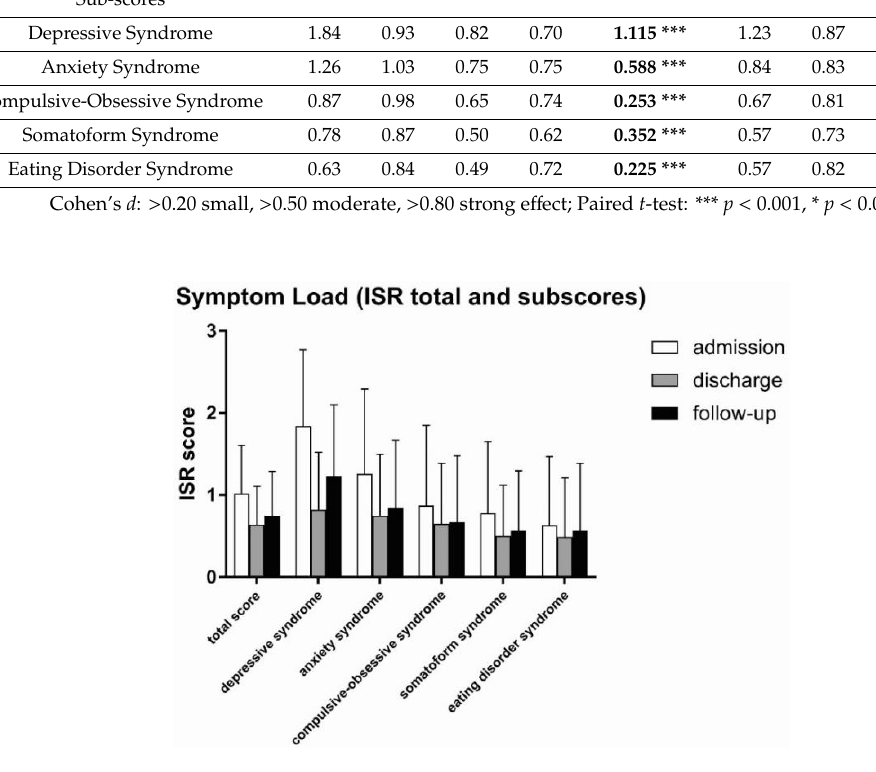
Figure 4. Effect of multimodal intervention. The scatter blots illustrate the effect of the multimodal intervention at ( A ) discharge from the TCM Hospital or ( B ) follow-up. Each dot represents one patient. The dots below the line represent patients who benefitted from intervention, the dots on the